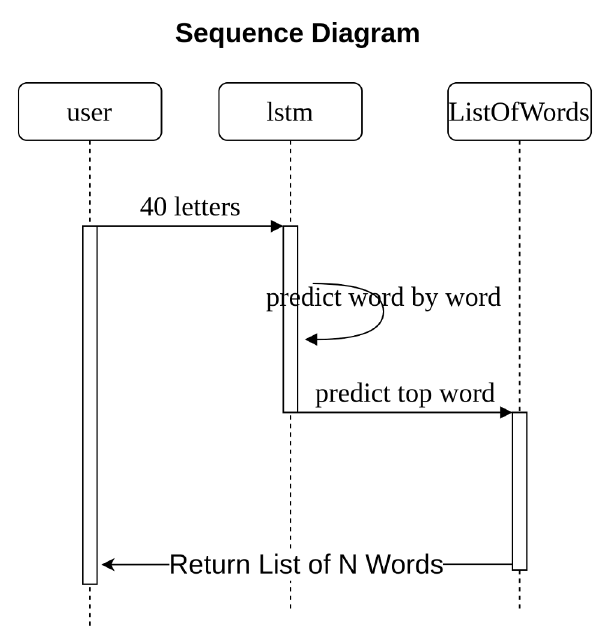
Figure 4. sequence diagram of application